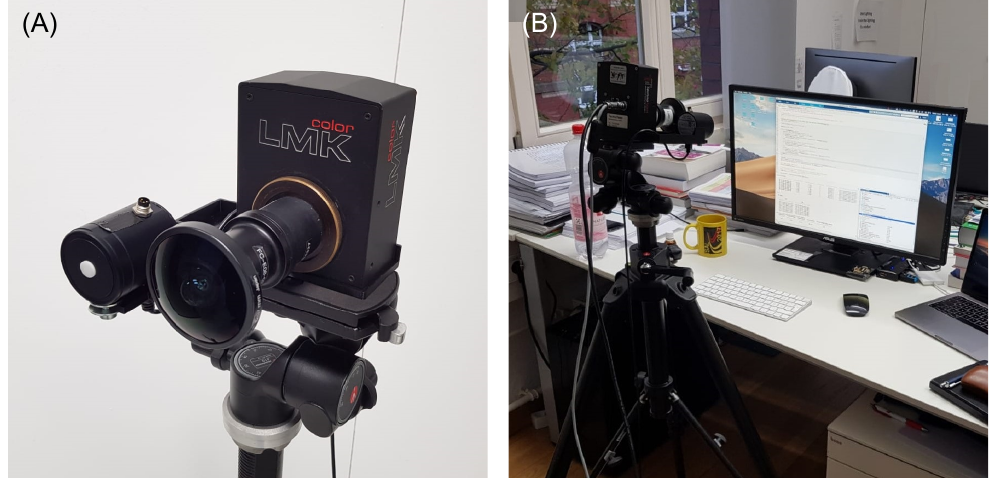
Figure 1. Measurement setup. ( A ) Luminance imaging photometer LMK-5 color with fisheye lens (right) and CSS-45 radiometer sensor (left) mounted both to the same camera tripod; ( B ) alignment of the measurement setup for assessing the NIF impact of the illumination of a typical display workplace and its